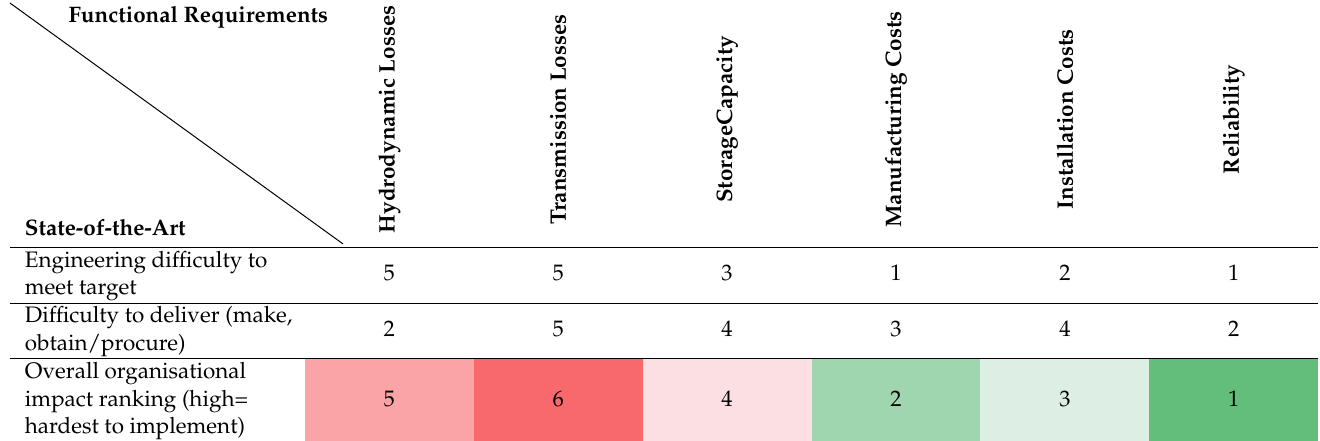
Table 11. Example of the organisation difficulties to meet the target and deliver each of the functional requirements for the tidal energy array improvement case. Red to green shading is used to highlight the overall organisational impact from hardest to implement (red) to easiest to implement